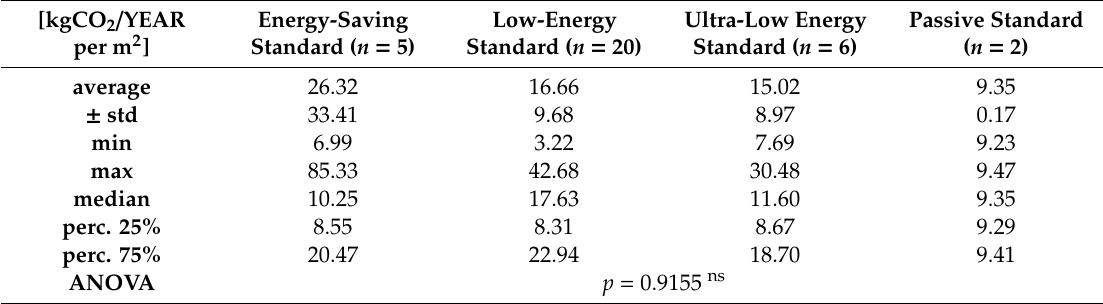
Table 5. Annual CO 2 production in relation to heating categorized according to energy standards calculated per m 2 of useful floor area of the analyzed panel wood